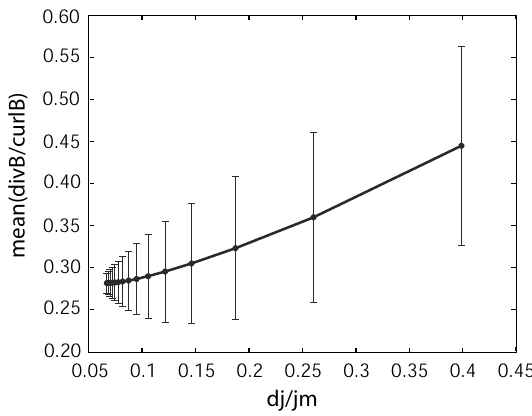
Fig. A2. Average ratio |∇· B | / |∇× B | with standard deviations (er- rorbars) versus relative error of the current density estimate for model λ